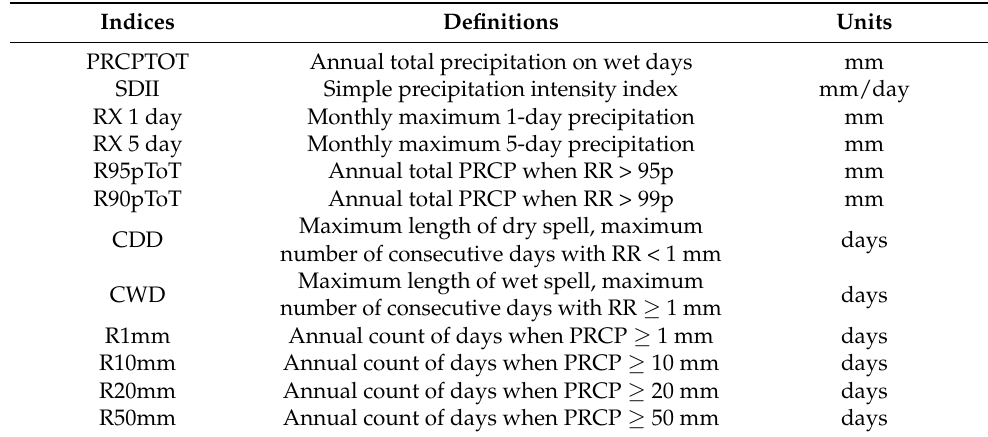
Table 1. Indices of climatic extremes calculated in the present